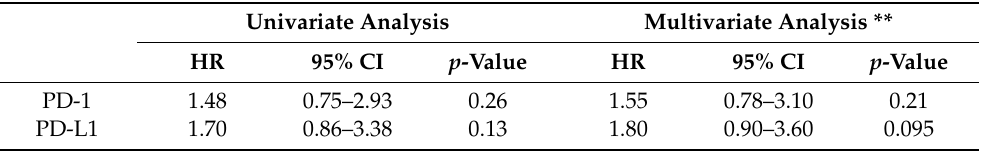
Table 3. Univariate and multivariate analysis of the plasma PD-1 and PD-L1 concentrations * at the time of inclusion for patients with GIST (group 2) .